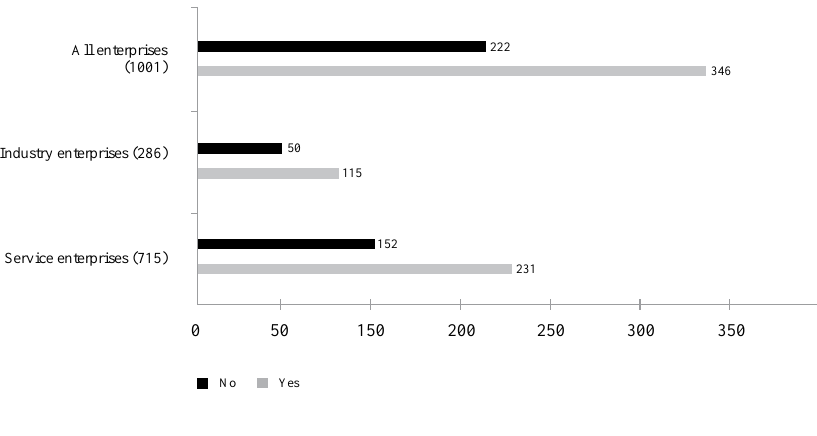
fig. 14. The benefit of governmental innovations